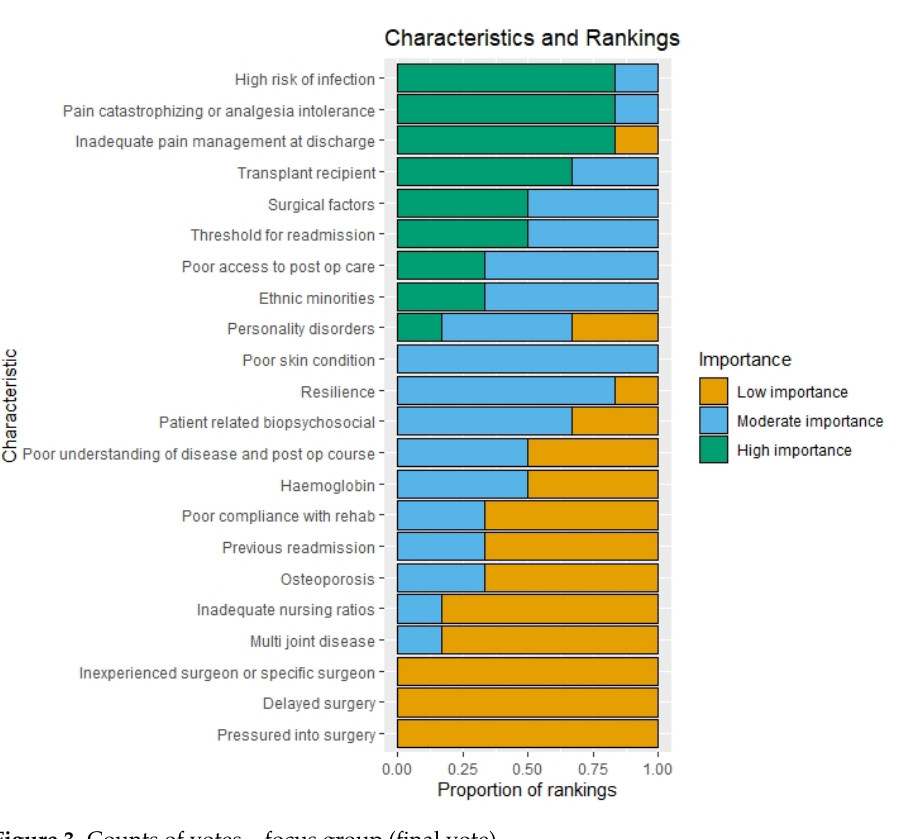
Figure 3. Counts of votes—focus group (final vote).